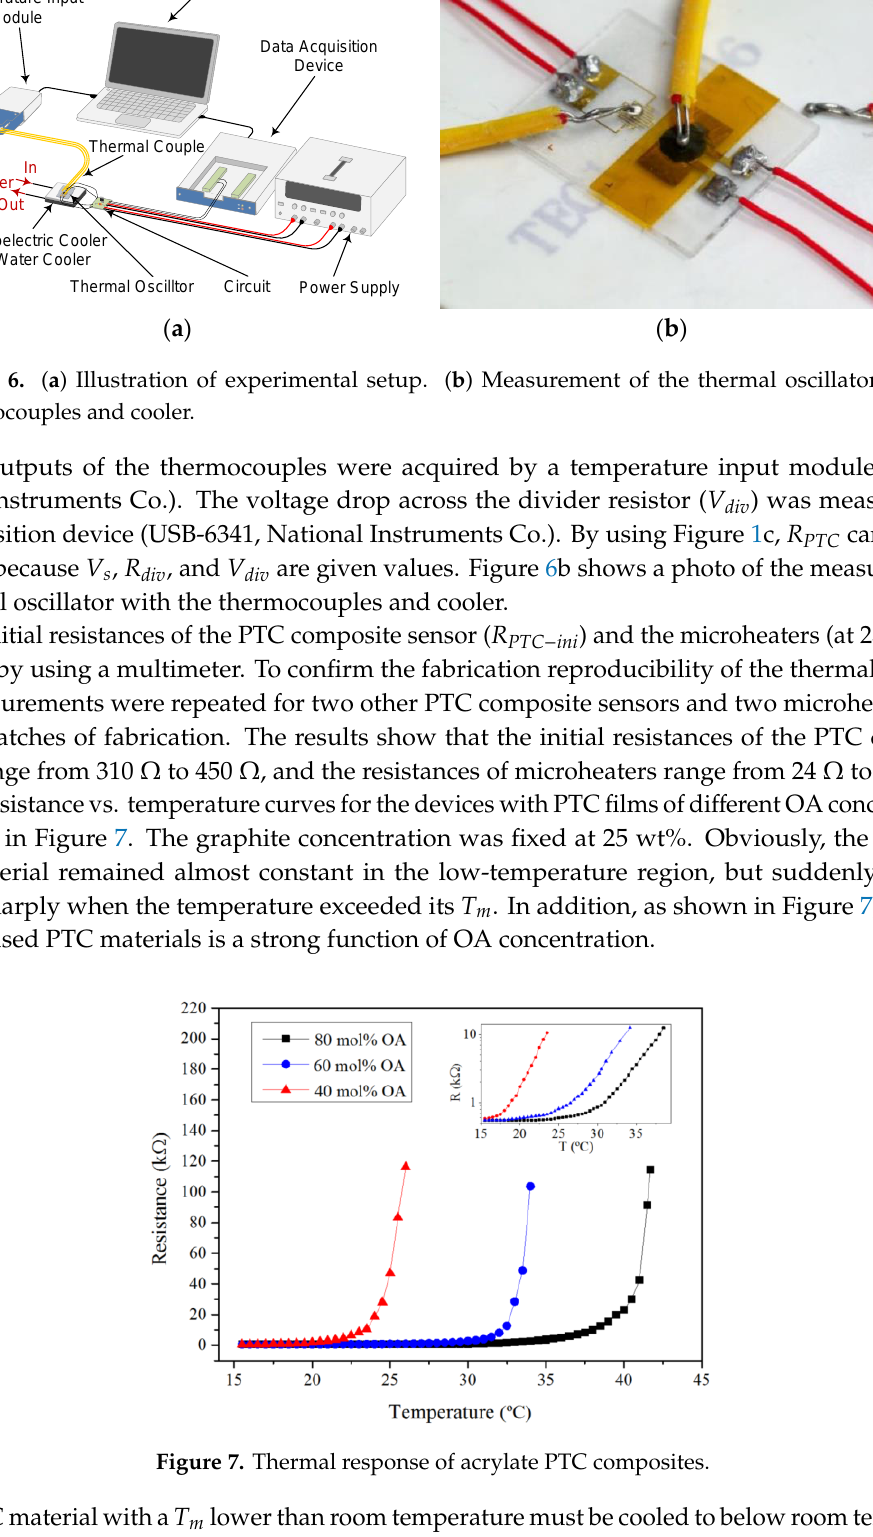
Figure 7. Thermal response of acrylate PTC composites.